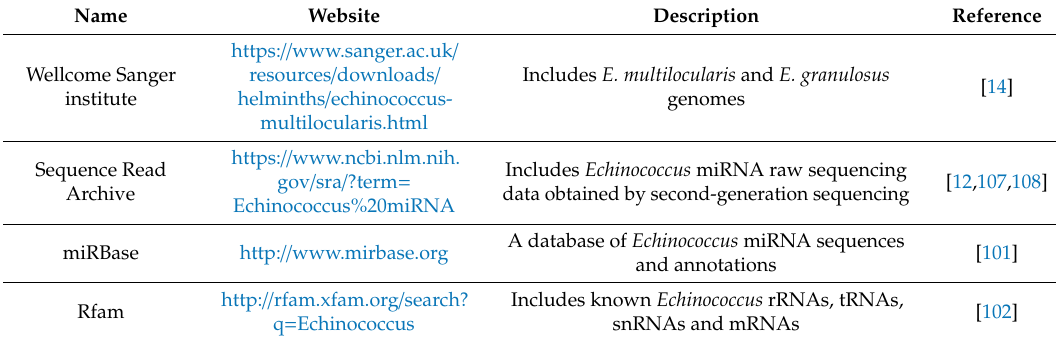
Table 4. Echinococcus miRNA-Related